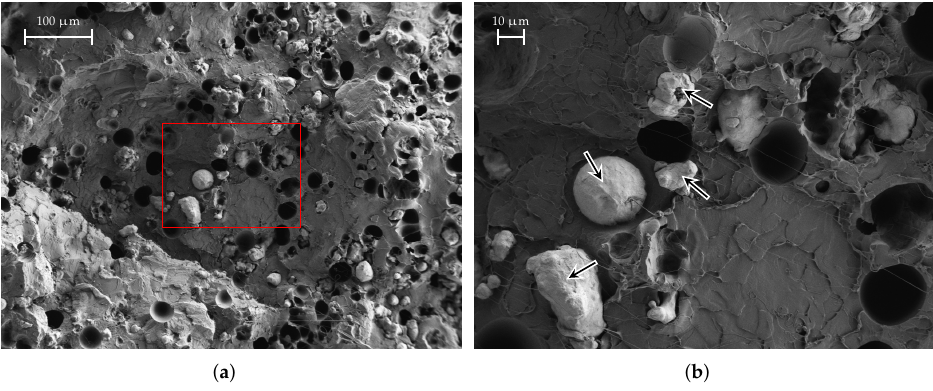
Figure 16. SEM images of a FEP material sample. The arrows indicate iron grains. The area marked in red is shown enlarged on the right. ( a ) FEP, medium magnification; ( b ) FEP, large magnification.